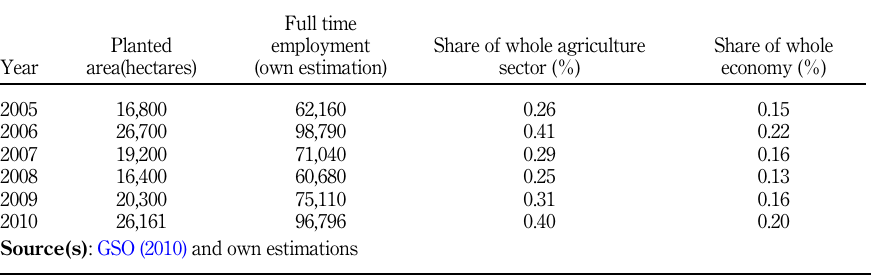
tobacco cultivation sector,